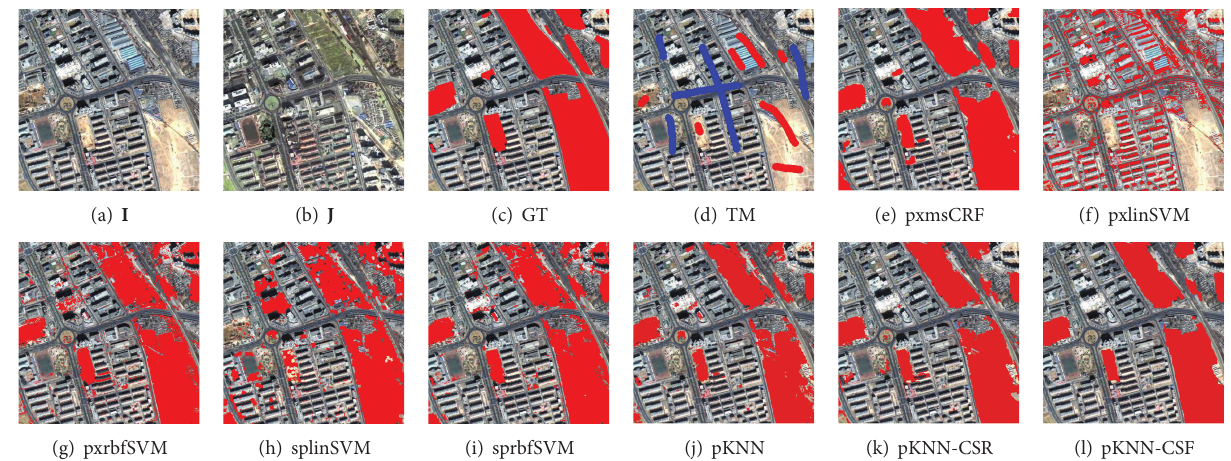
Figure 4: DS1 and the resultant change maps (CMs) by different methods. In the ground truth (GT) images and the CMs, the red regions denote the changed class and the other regions denote the unchanged class. In the training mask (TM) images, the red regions denote the changed class, the blue regions denote the unchanged class, and the remaining regions are unlabeled.